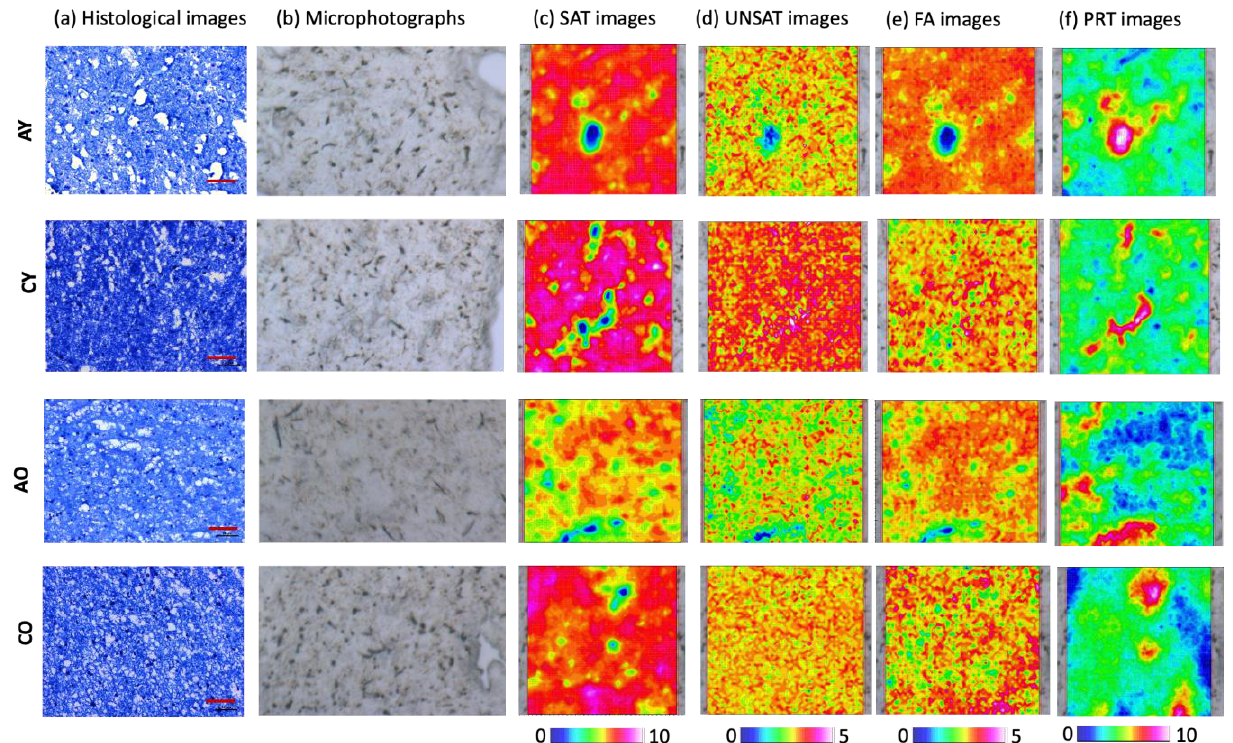
Figure 2. Imaging analysis of representative A and C sections of Y and O experimental groups. ( a ) Histological images stained with the Luxol Fast Blue sec. Klüwer-Barrera kit (myelin is colored in turquoise color, while neurons and glial nuclei are violet; scale bar 50 µ m, magnification 20 × ). ( b ) Microphotographs and corresponding false-color images showing the topographical distribution of ( c ) saturated (SAT) and ( d ) unsaturated (UNSAT) lipids, ( e ) fatty acids (FA), and ( f ) proteins (PRT). False-color images were composed of 4096 pixel/spectra with a spatial resolution of 2.56 μm; the dimensions were 164 × 164 μm. Different scales were adopted to highlight the different macromolecular compounds (blue color indicates areas with the lowest absorbance values, while pink/white colors the highest ones).